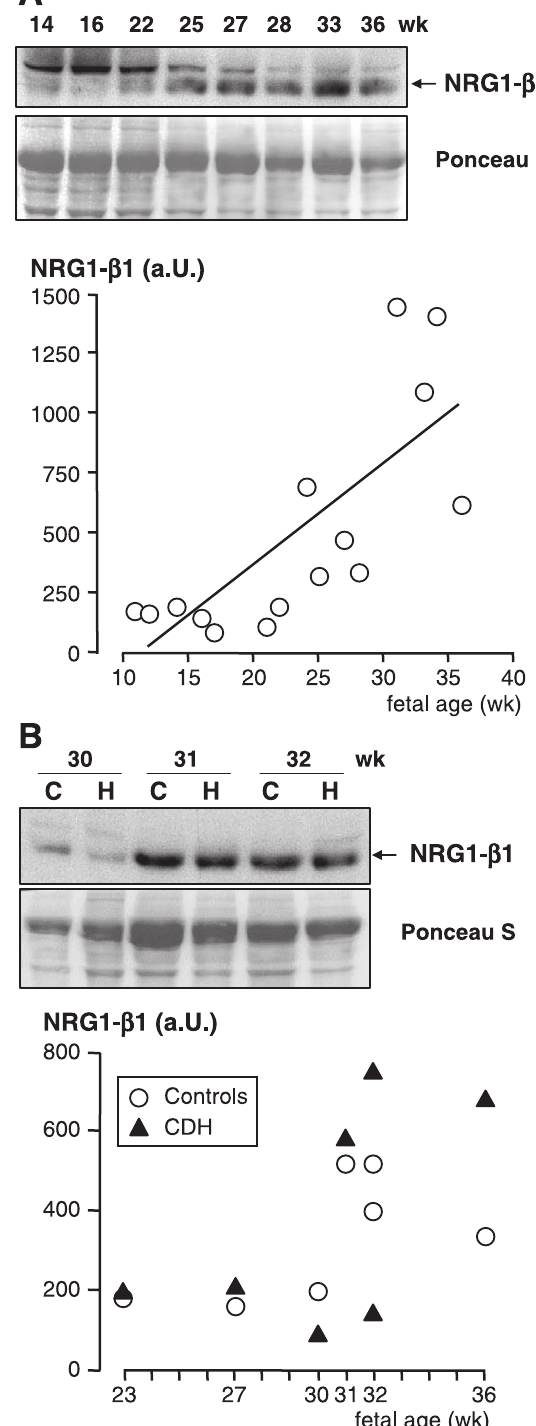
Figure 5. NRG1- b 1 in Human Fetal Lungs (A) Developmental changes in control lungs were studied from 11 to 36 wk of pregnancy. Upper: representative Western blot. A 45-kDa band corresponds to NRG1- b 1 (the 55-kDa band is nonspecific [61]). Lower: densitometric analysis (arbitrary units [a.U.]) in 15 individuals showing a significant linear increase ( r ¼ 0.75, p ¼ 0.001). (B) Comparative study in seven pairs of age-matched CDH (lanes labeled H) and control (lanes labeled C) lungs. Upper: representative Western blot. Lower: densitometric analysis; there was no significant difference in expression level between CDH and control lungs ( p ¼ 0.58).